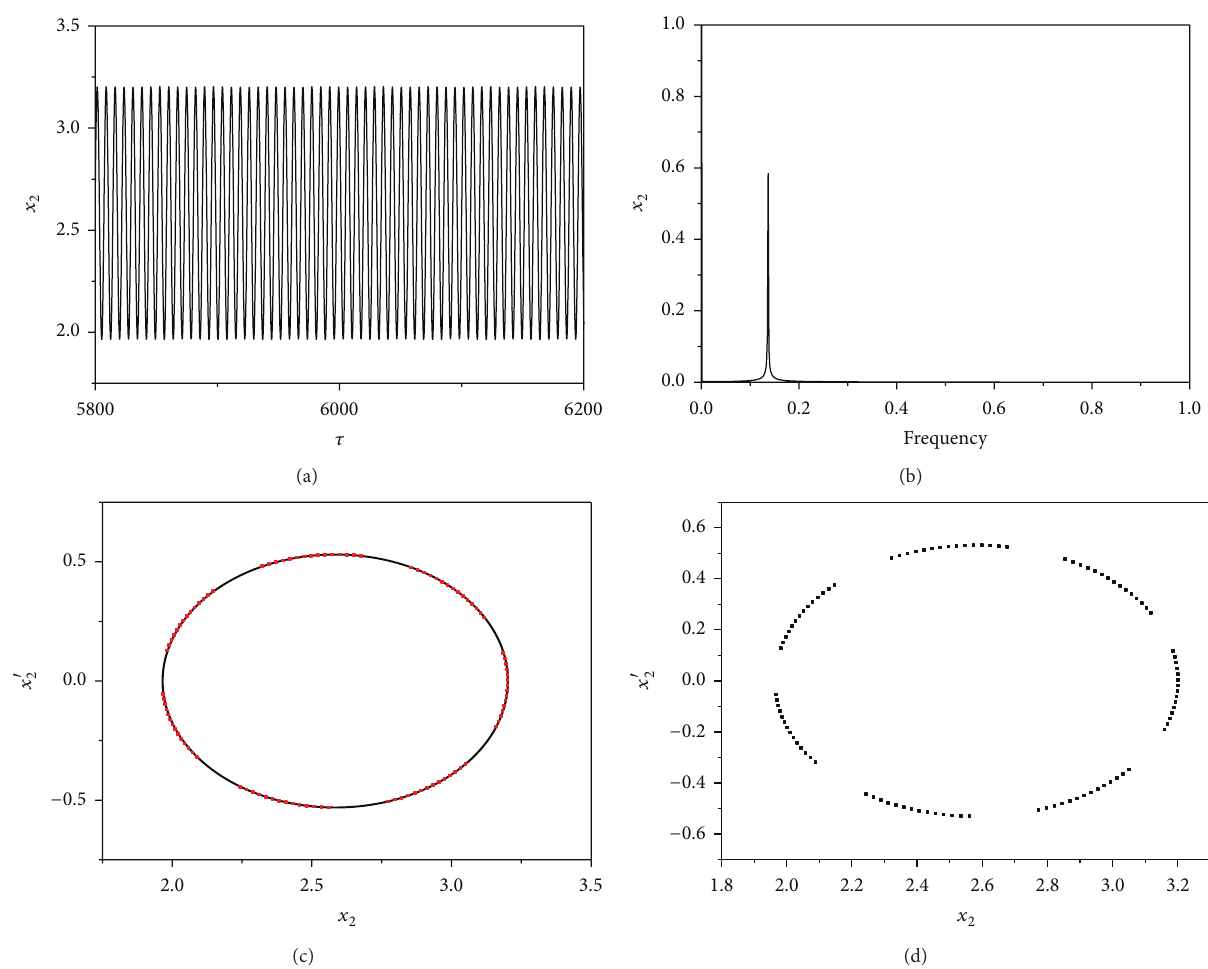
Figure 19: See 𝜔 = 0.735 . (a) Displacement response. (b) Frequency spectrum. (c) Phase-portrait plots. (d) Poincar´e maps.